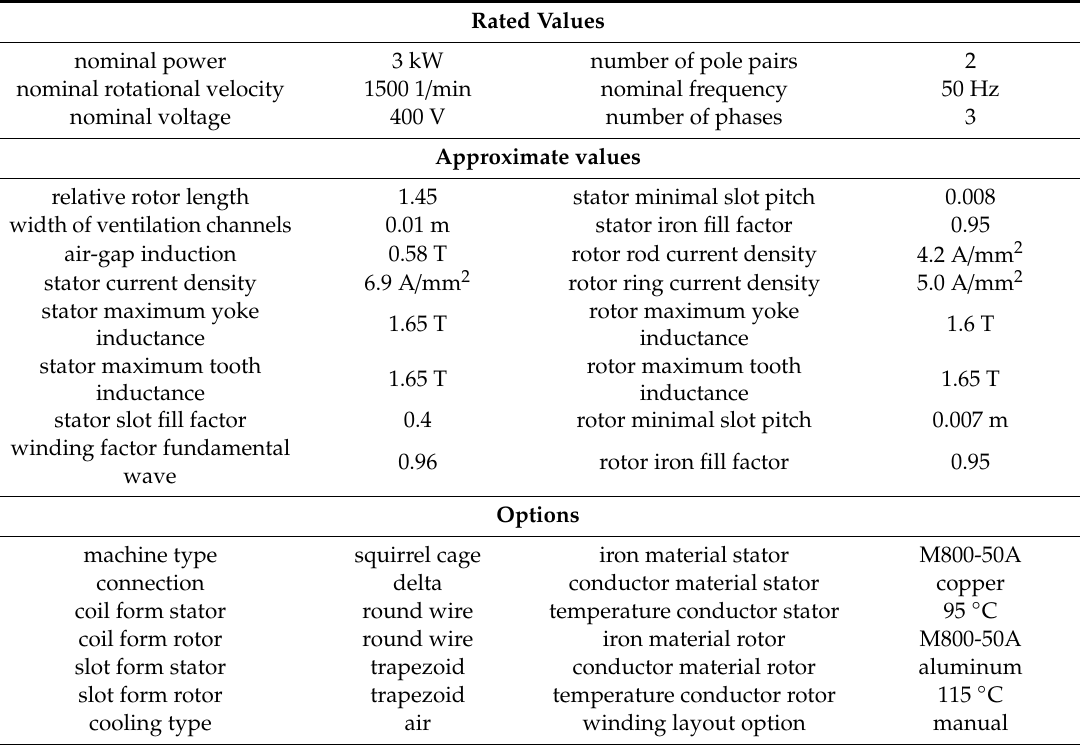
Table 3. Input parameters for validation of main dimensions—calculation example